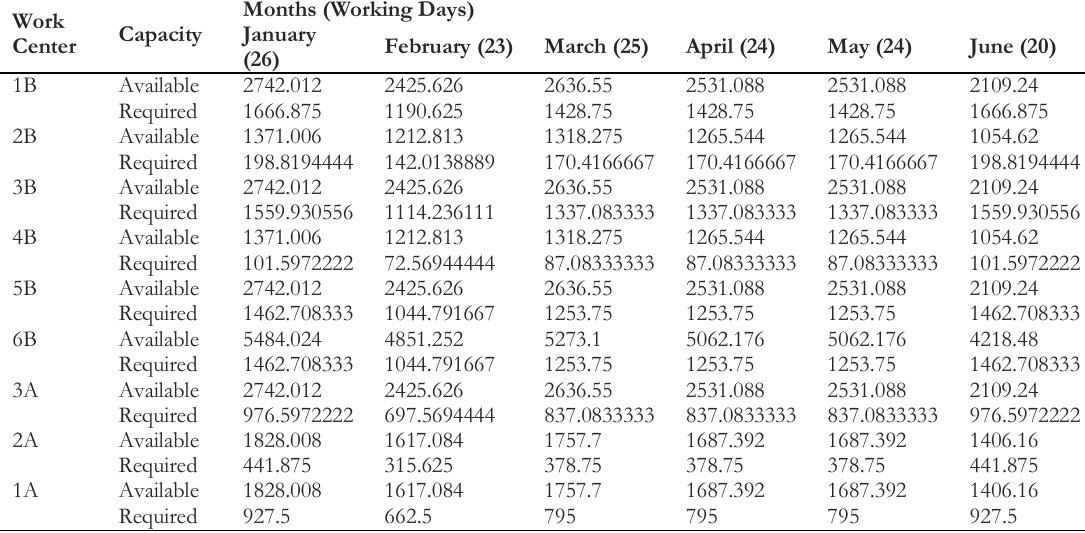
Table 12. CRP for